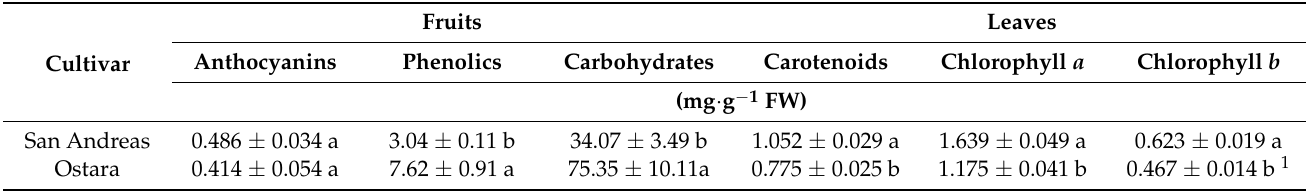
Table 5. Contents of pigments (anthocyanins, carotenoids, chlorophyll a , chlorophyll b ), phenolics, and carbohydrates in fresh fruits or leaves of two strawberry cultivars.